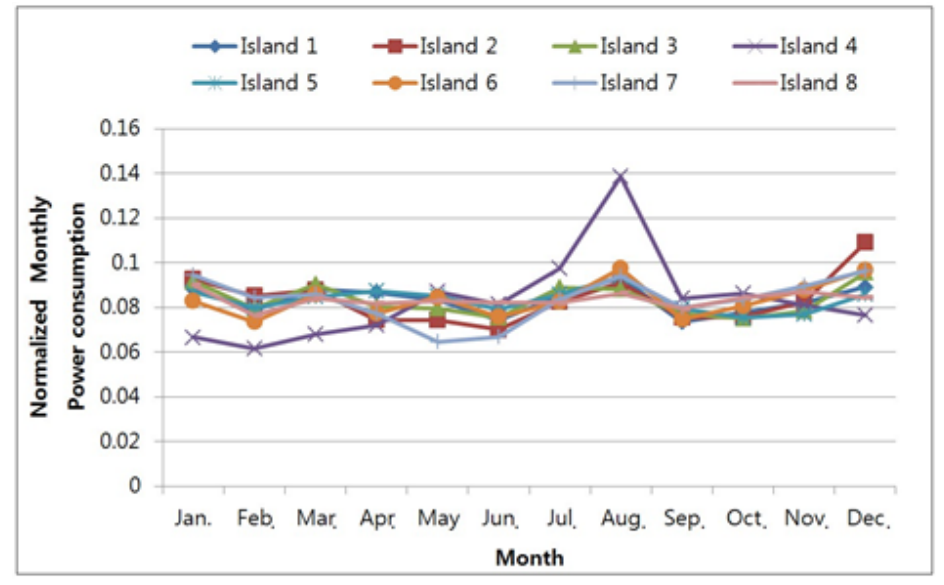
Figure 4. Normalized monthly power consumption with months for 1